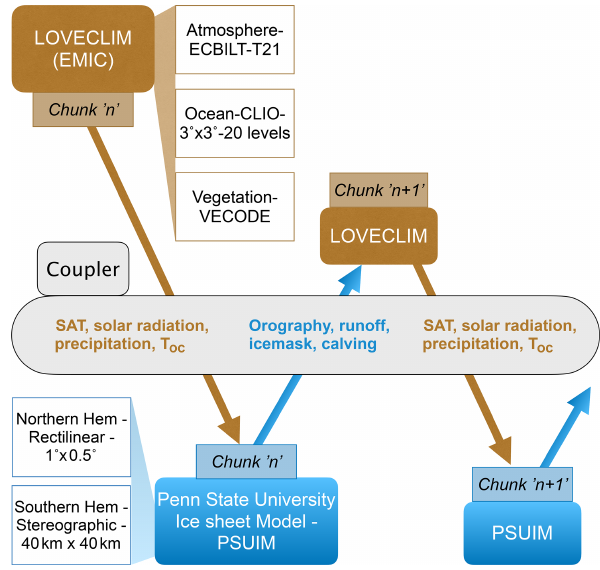
Figure 2. Schematic of the coupling between LOVECLIM and PSUIM. SAT is the surface air temperature and T oc is the ocean temperature at a depth of 400m. Refer to Sect. 2.3 for